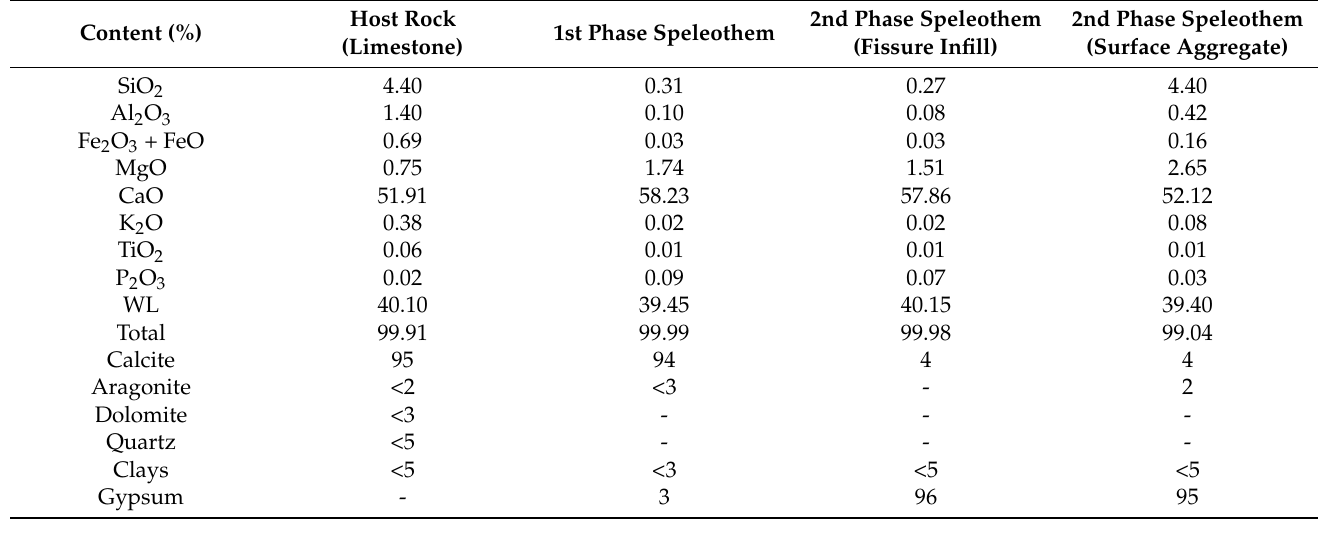
Table 1. Average chemical composition (XRF analysis) of the different materials associated with cave paintings. (WL: weight loss).